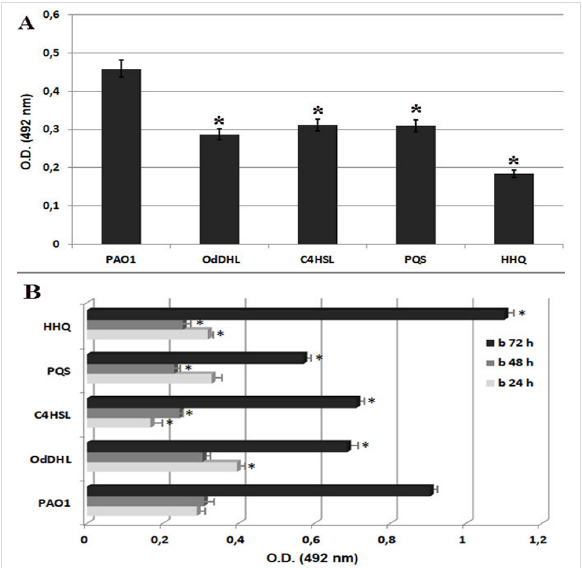
Figure 1: Graphic representation of the bacterial adherence to inert substrata (A) and biofilms developed after 24 h, 48 h and 72 h of incu- bation (B) in the presence of 20 µM purified QSSMs (* P < 0.05, based on ANOVA and Bonferroni post test of medians of 3 independent ex- periments performed in triplicate).